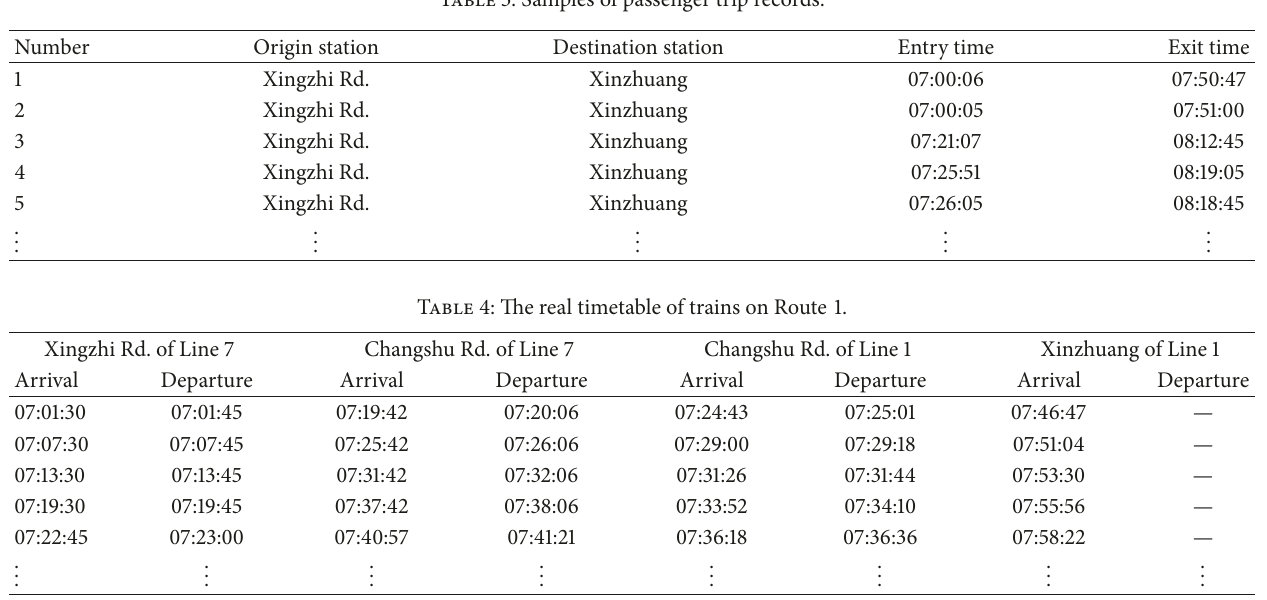
Table 3: Samples of passenger trip records.